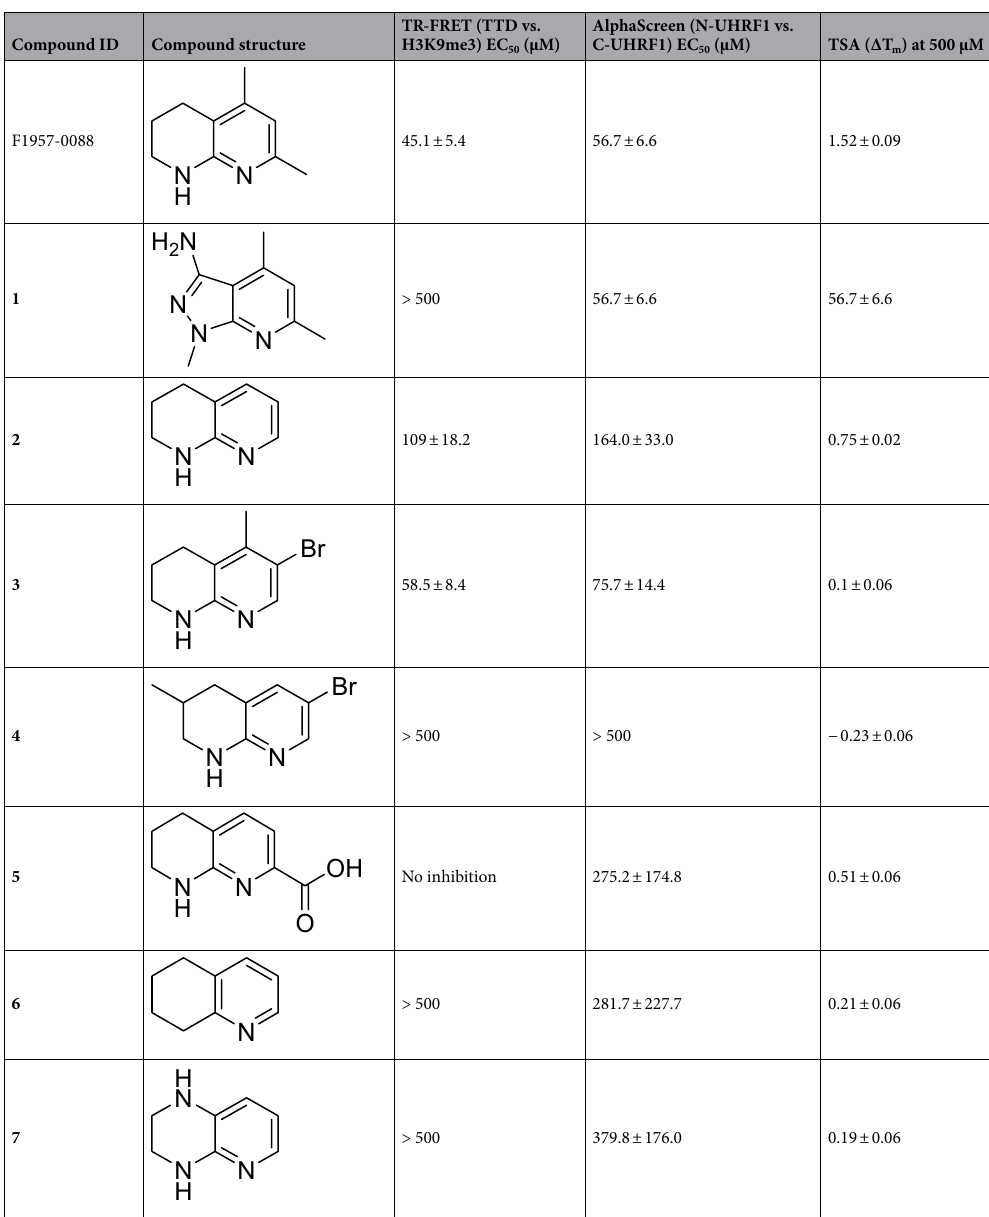
Table 1. The structure activity relationship (SAR) of F1957-0088 homologs with fused-bicyclic ring system. The EC 50 of TR-FRET and AlphaScreen assays are reported as EC 50 ± S.E.M. and the ΔT m of TSA assay are reported as mean ± S.D. n=3 for AlphaScreen, TR-FRET, and TSA. Note that “no inhibition” means little to no change in assay readout even at the highest compound concentration tested (1 mM) while “> 500” means there is assay signal reduction/inhibition at highest concentrations yet the EC 50 determined by curve fitting is above 500